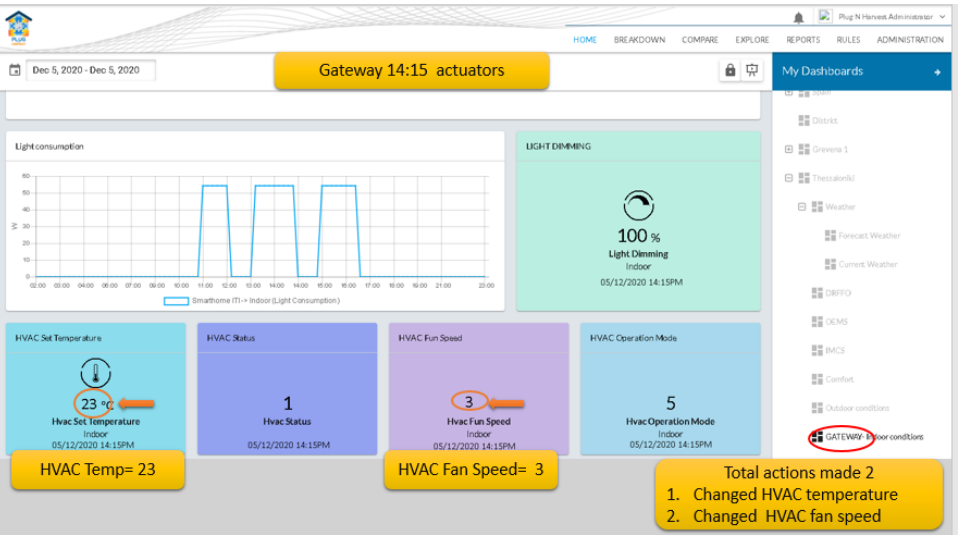
Figure 18. Next state status data and information from the P-n-H Gateway after the control actions. Table 3. Overall validation